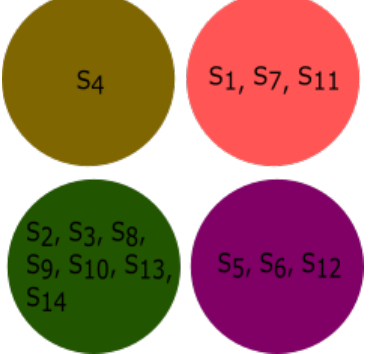
Figure 7. Clusters based on secondary structure using k-means algorithm. Here, S i indicates the species name as specified in Table